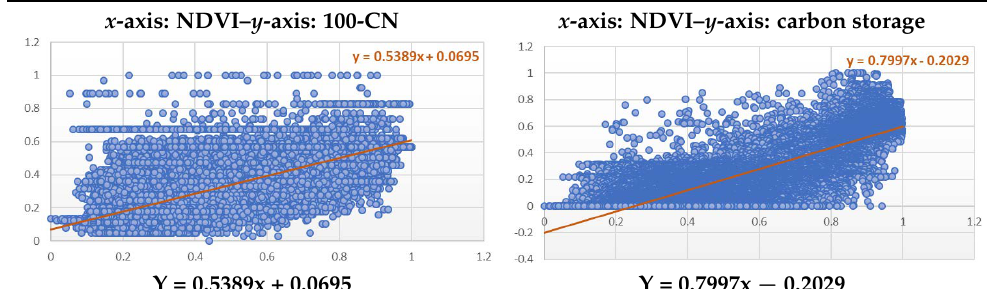
Table A1. Linear regression slopes: entire study